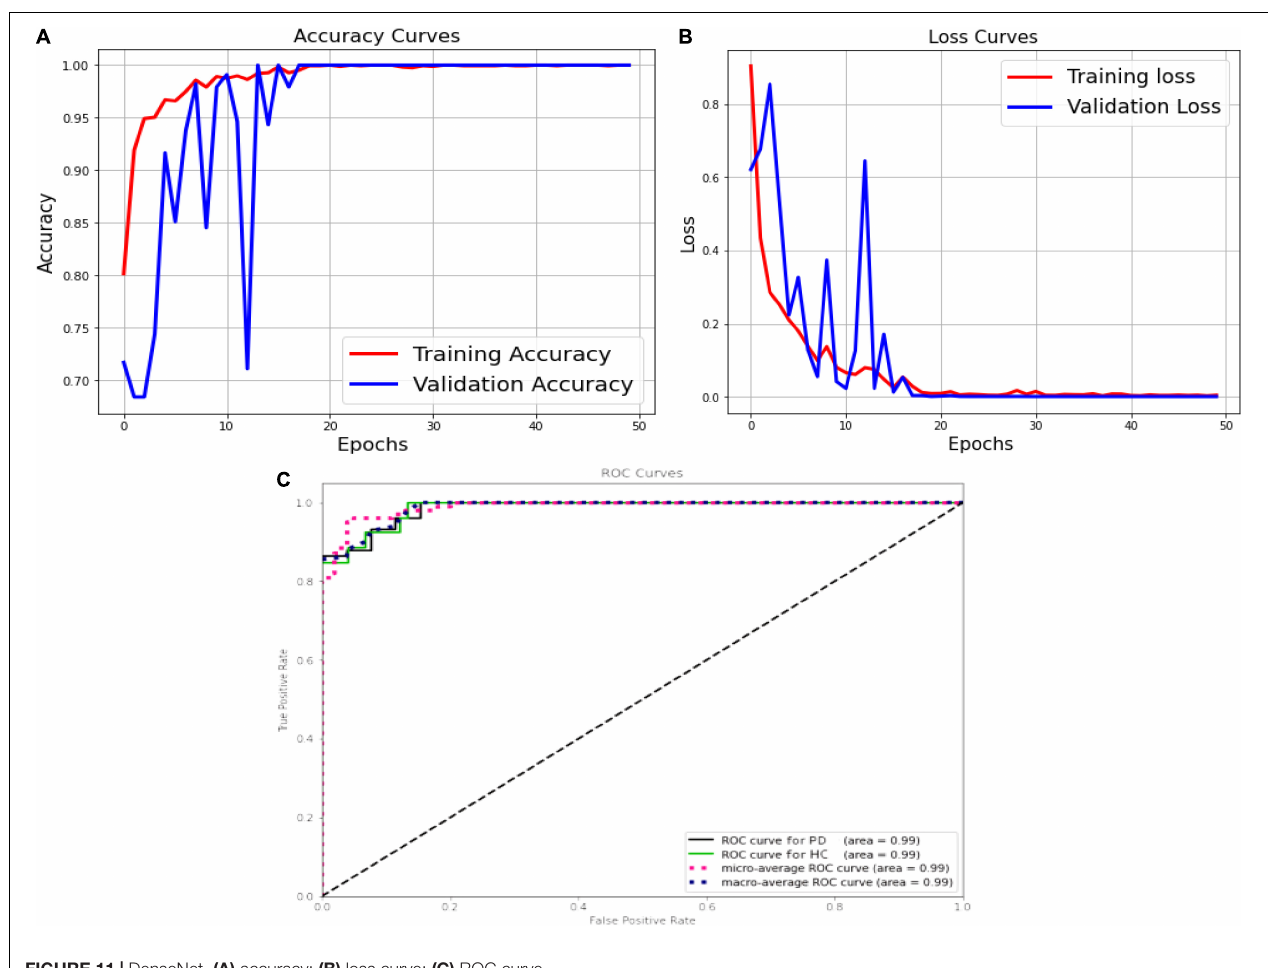
FIGURE 11 | DenseNet, (A) accuracy; (B) loss curve; (C) ROC curve.